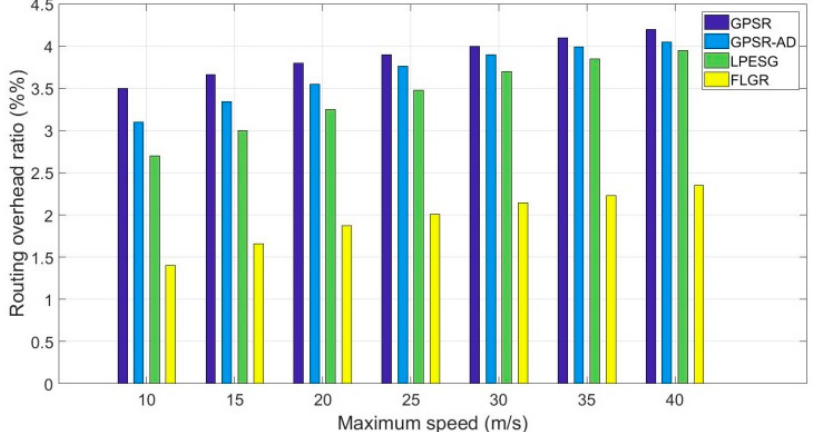
Figure 11. Impact of maximum speed on routing overhead ratio with 140 n = .